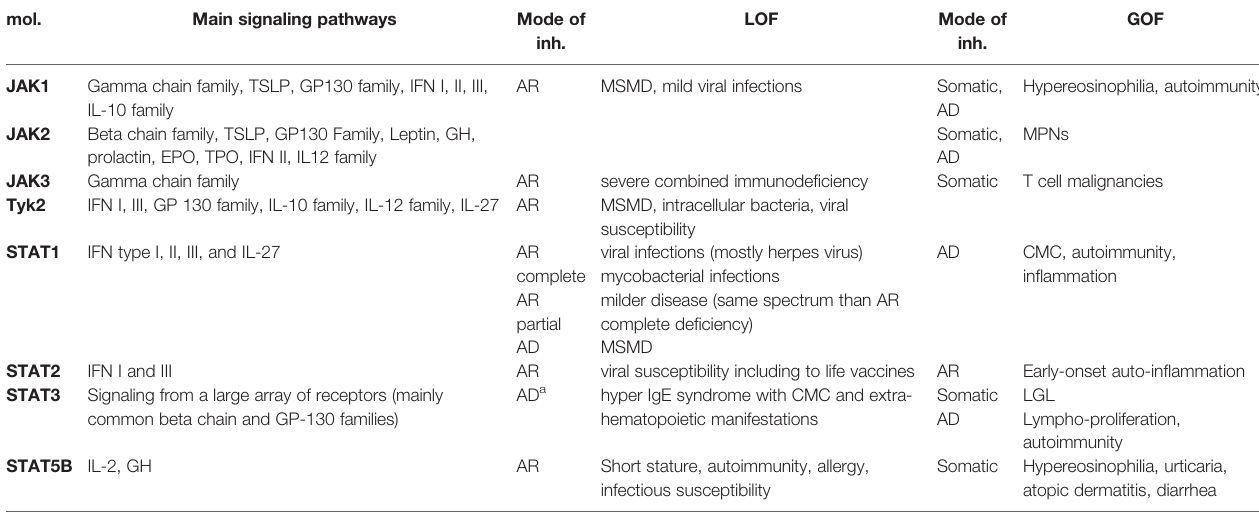
TABLE 1 | Main IEIs and hematologic conditions in humans related to germline and somatic mutations in members of the JAK-STAT pathway.